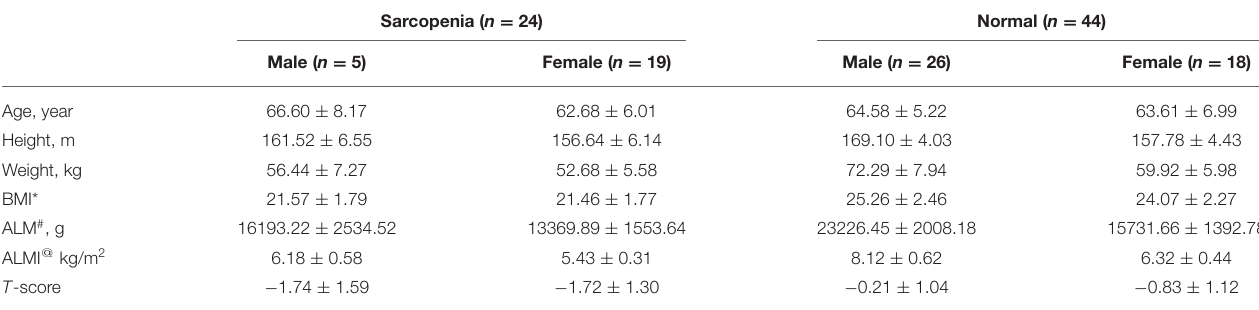
TABLE 1 | Basic information of the participants.